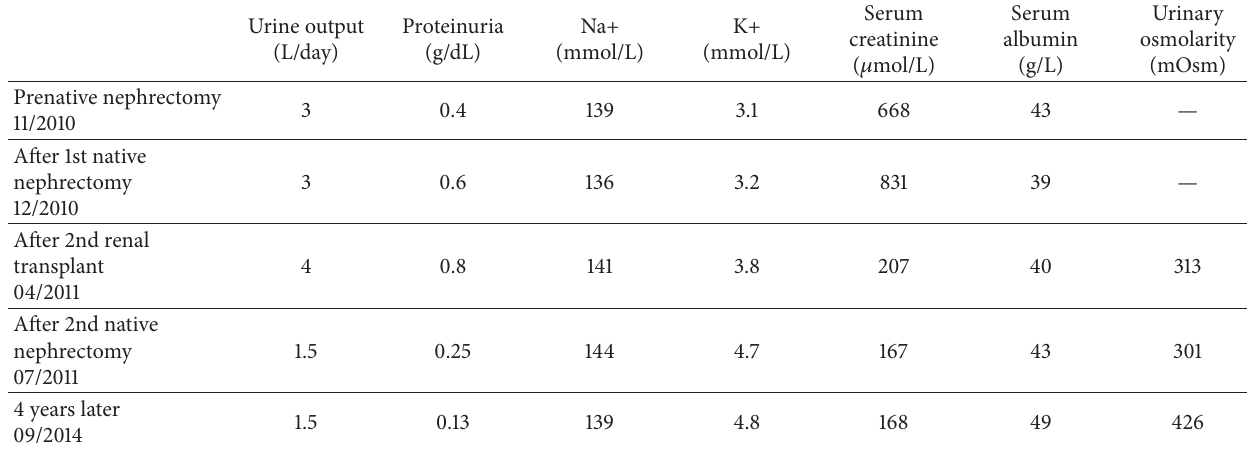
Table 1: Serum and urinary changes before and after